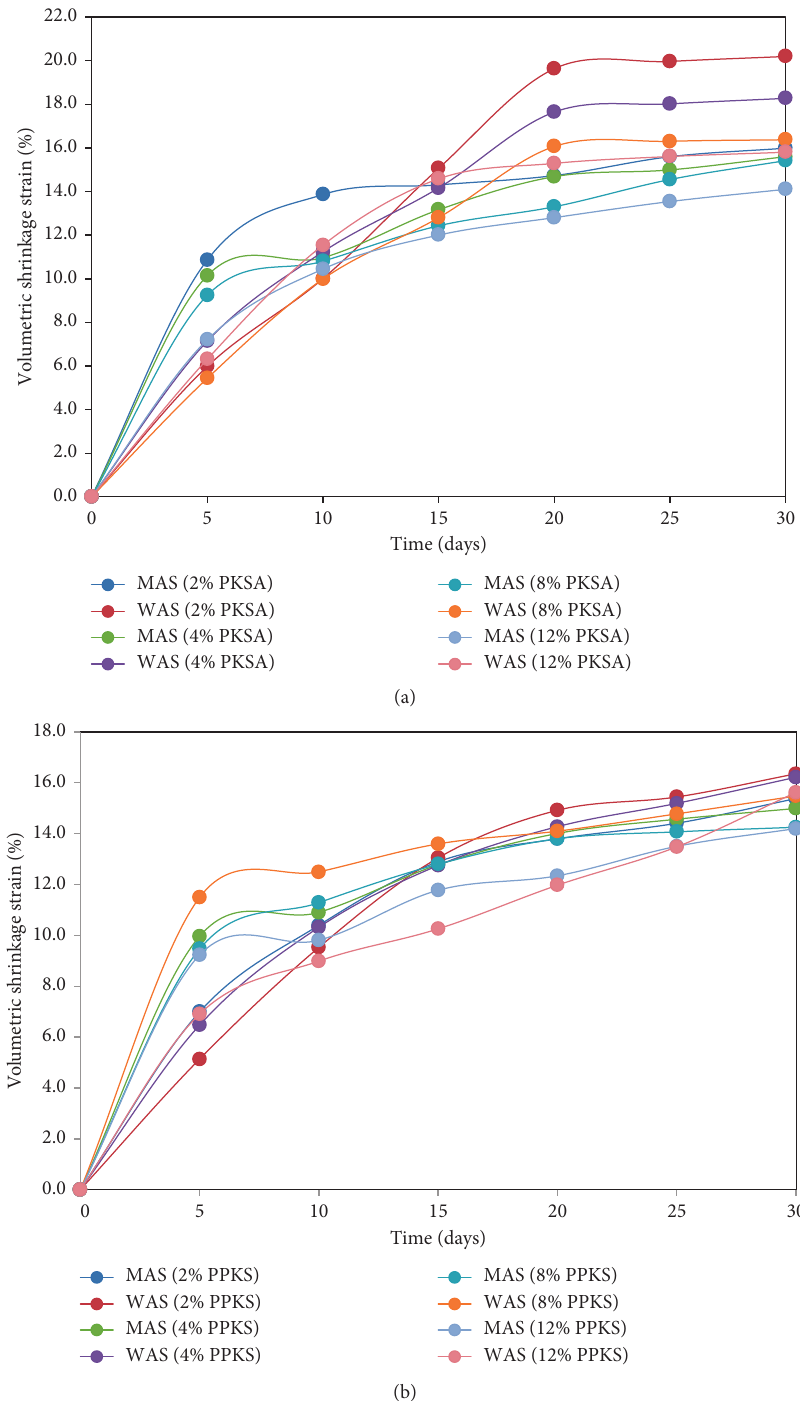
Figure 10: Volumetric shrinkage strain with